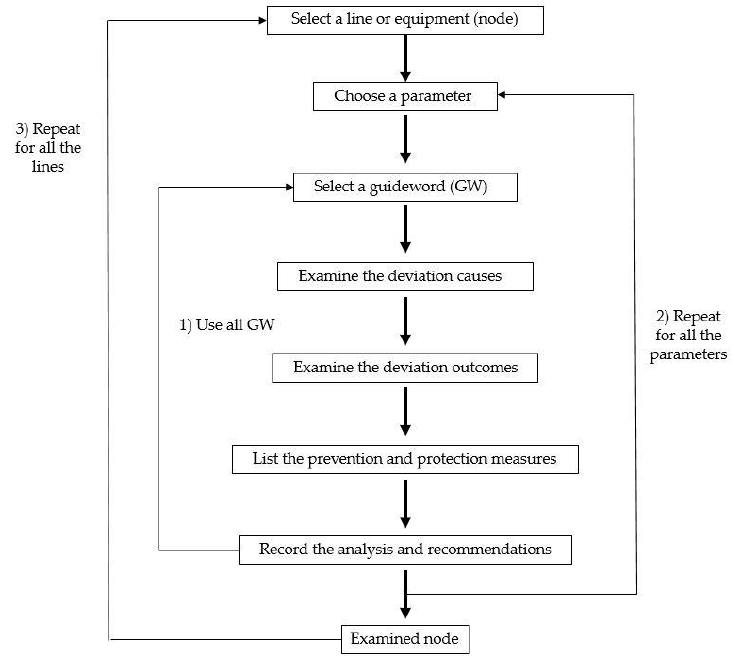
Figure 1. HAZOP flowsheet.